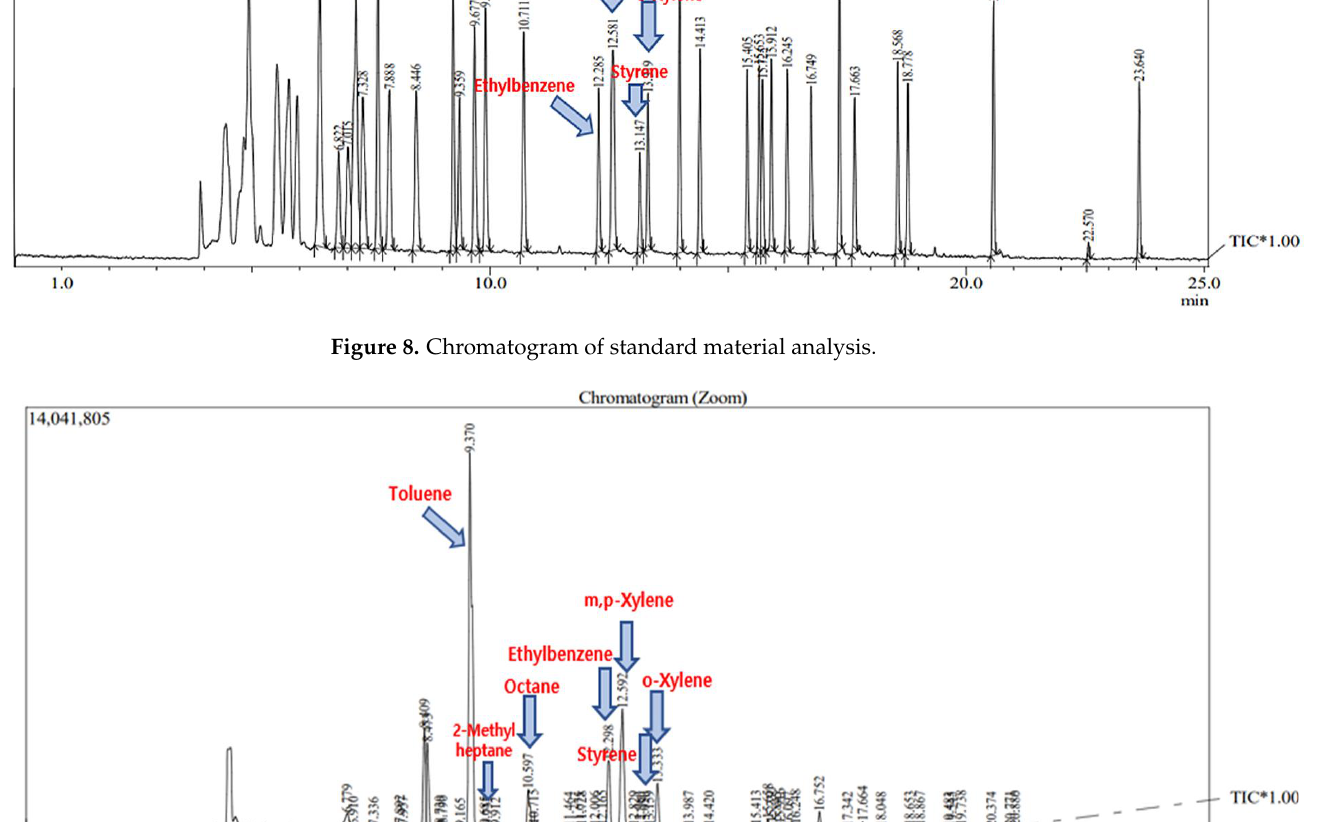
Figure 9. The chromatogram analyzing the 3–4 pm measurement point, the measuring point 5 of Business site A.